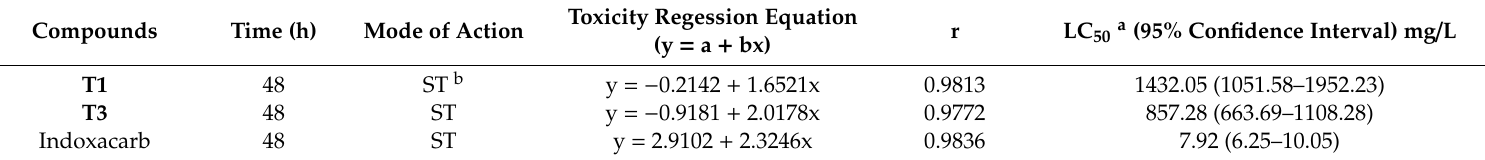
Table 5. Insecticidal activity of compounds against P.